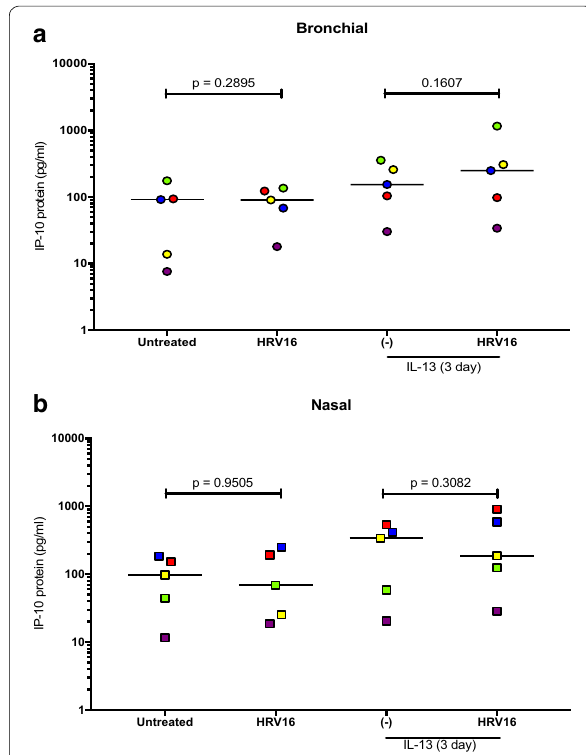
Fig. 5 IP-10 production in paired human primary bronchial ( a ) and nasal ( b ) epithelial cells under the submerged culture. IP-10 was measured in supernatants of cells treated with or without IL-13 and/ or human rhinovirus (HRV16). Each of the colored solid circles (n subjects) represents the data from an individual subject. The horizon- tal lines indicate